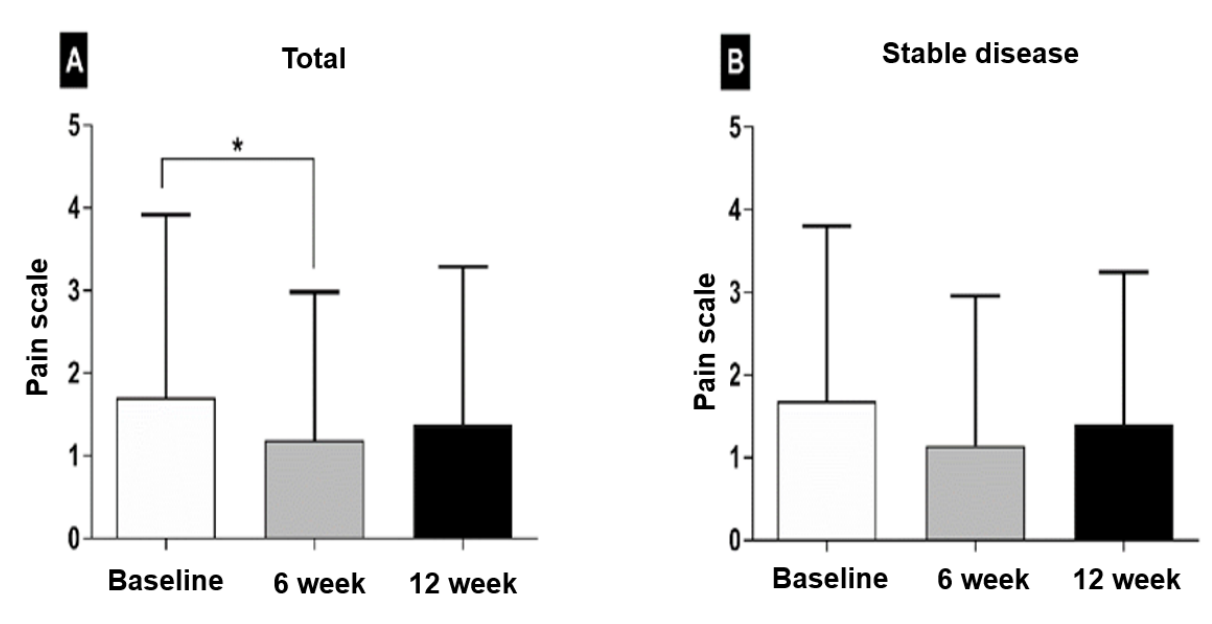
Figure 2. Pain scale. The pain severity, assessed by numeric rating scale, significantly decreased at 6 weeks but increased at 12 weeks (A). There was no significant improvement in patients with stable tumor response